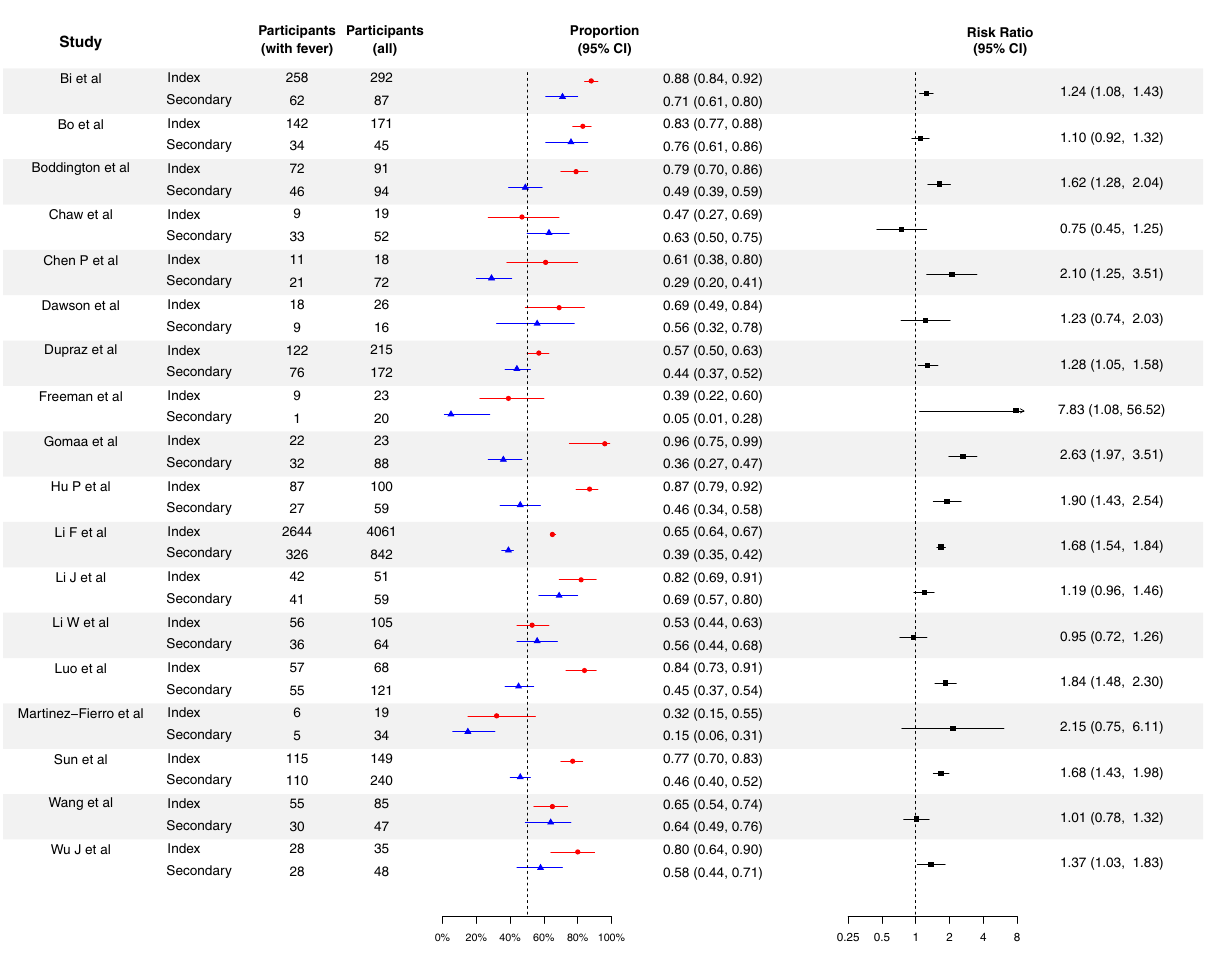
Fig. 1 Proportion of cases with fever for the index cases and secondary cases for COVID-19, and their corresponding risk ratio of index cases, compared with secondary cases. Red circles and lines indicate the proportion of fever of index cases and the corresponding 95% exact binomial con fi dence intervals. Blue triangles and lines indicate the proportion of fever of secondary cases and the corresponding 95% con fi dence intervals. Black squares and lines indicate the risk ratio of proportion of fever of index cases compared with secondary cases and the corresponding 95% con fi dence intervals calculated based on normal approximation. All statistical tests are two-sided tests. Adjustments are not made for multiple